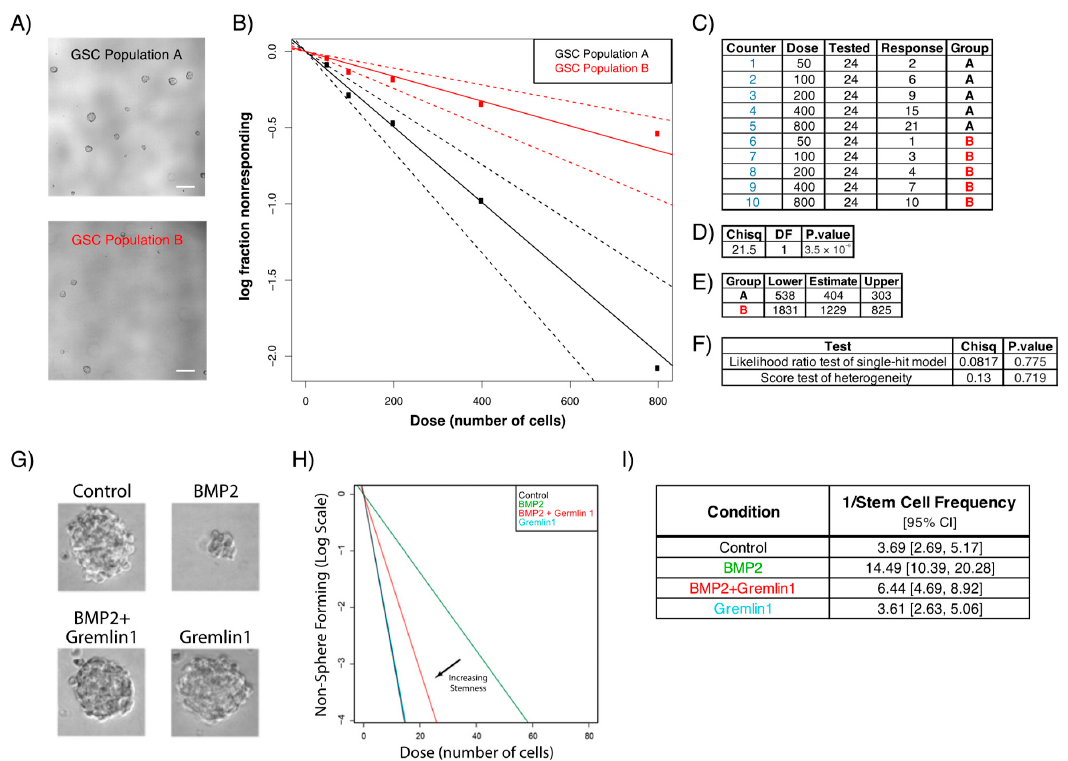
Figure 2. In vitro analysis of GSC self-renewal using the limiting dilution assay. GSCs are dissociated into single cells and di ff erent amounts are plated in di ff erent wells. The number of wells containing spheres is then evaluated and micrographs are obtained to visualize sphere morphology. In the examples provided, sphere formation assays are performed on di ff erent GSC populations to evaluate their stemness and clonogenic potential. ( A ) Micrographs of GSC population A (top) and GSC population B (bottom); scale bar, 200 µ m. ( B ) The amount of initially seeded cells ( x -axis) is plotted against the log fraction of non-responders corresponding to wells without any detected spheres ( y -axis). The slope of the line represents the log-active cell fraction. ( C ) Data obtained using the limiting dilution assay entered into the extreme limited dilution assay (ELDA) tool. ( D ) Overall test for di ff erences in stem cell frequencies between the two groups. ( E ) Confidence intervals for 1 / (stem cell frequency). ( F ) Goodness of fit tests. ( G ) Representative images of neurospheres formed by 3565 GSCs following 10 days of Bone Morphogenetic Protein 2 (BMP2) and / or Gremlin1 treatment. ( H ) In vitro limiting dilution assay and ( I ) quantification following 10 days of BMP2 and / or Gremlin1 treatments. ( G – I ) Reproduced and adapted with permission from Yan et al., Genes & Development; published by Cold Spring Harbor Laboratory Press, 2014 [51].